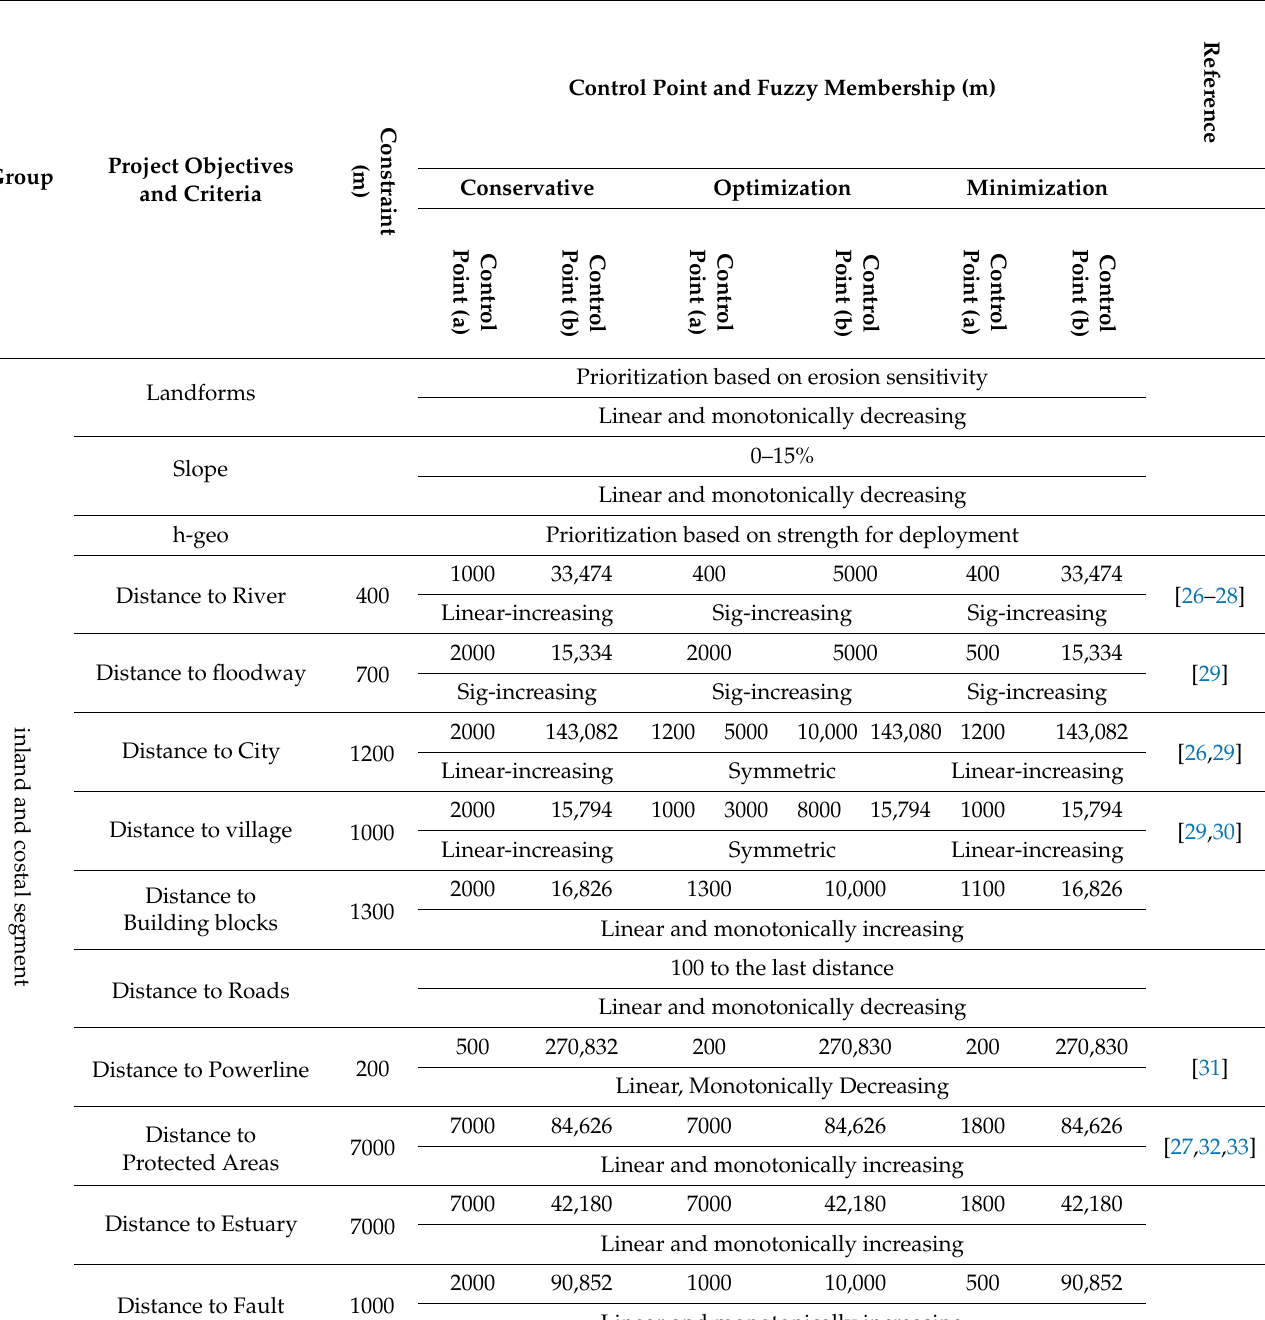
Table 2. Constraint, type, and form of fuzzy membership functions for research’s